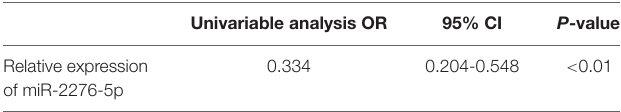
TABLE 2 | The result of univariate logistic regression analysis in glioma patients.